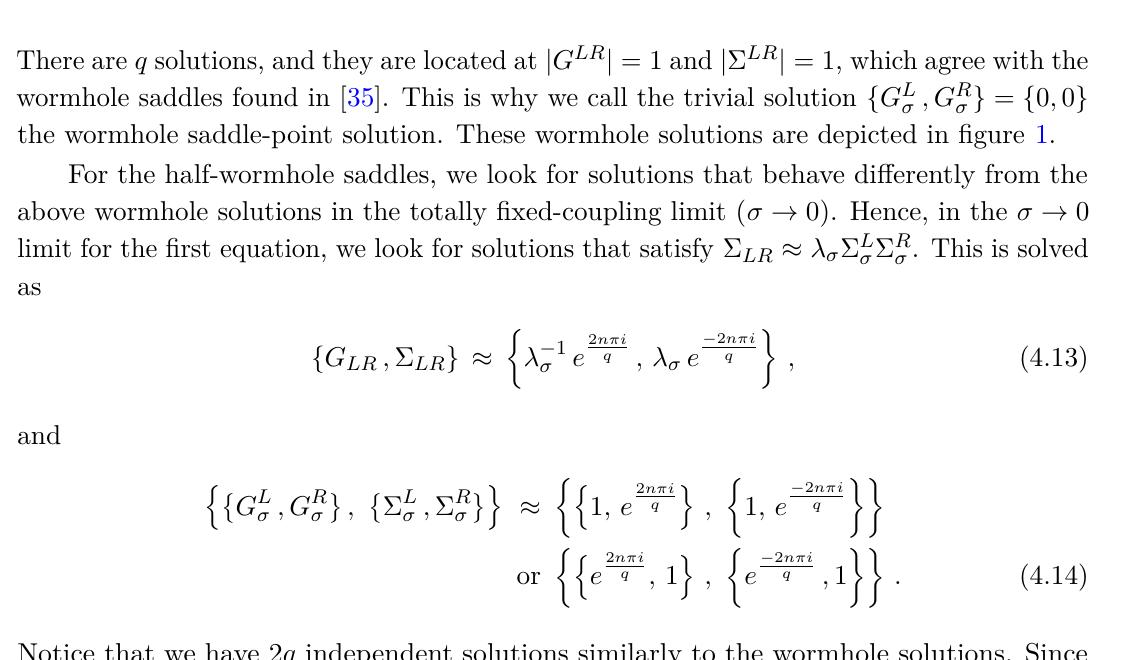
Figure 1 . The wormhole saddles for q = 12